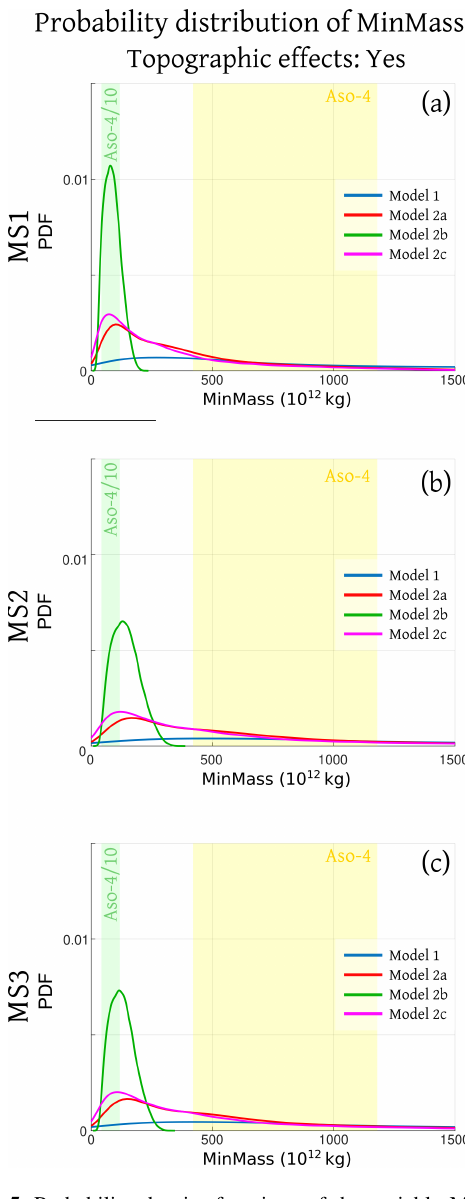
Figure 5. Probability density functions of the variable MinMass, calculated using models 1, 2a, 2b, 2c. MinMass represents the mass of pyroclasts in a PDC flow required to invade the marker sites MS1–MS3, related to maximum runout distances allowing the flow to overcome possible topography shielding effects near the marker sites. Estimates of the mass associated with the PDCs produced dur- ing the largest caldera-forming eruption of Aso are included: Aso- 4 / 10, possibly representing the Aso-4T unit, in green; Aso-4, total PDC overflow, in yellow (Takarada and Hoshizumi, 2020). Plots based on 100000 statistical samples.